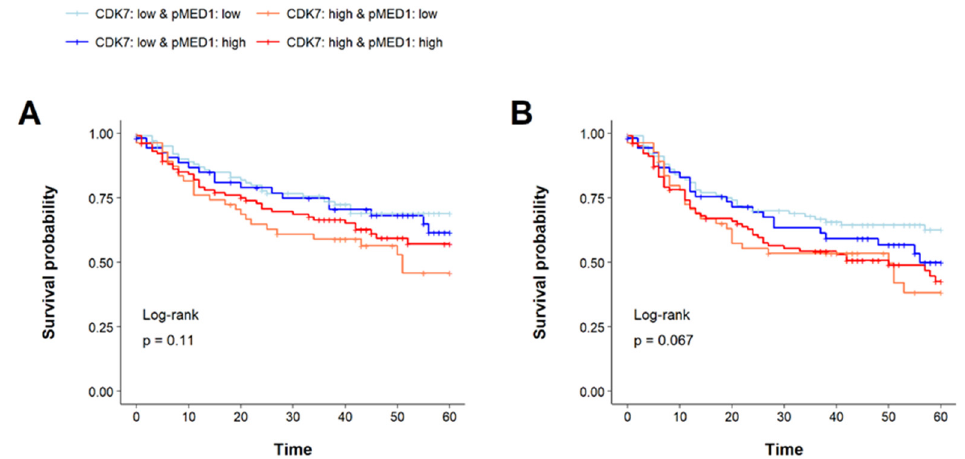
Figure 6. Kaplan–Meier graphs with p -values acquired from log-rank tests of ( A ) 5-year OS and ( B ) 5-year DFS. The cohort was stratified into four groups based on CDK7 and pMED1 expression. The expression above the median for the respective protein was considered as a high expression, the expression below the median as low expression. Based on this classification, four groups were formed to display all possible combinations of expression patterns. The log-rank tests revealed no significant difference in 5-year OS or 5-year DFS for the four groups. Nonetheless, we observed that curves grouped by CDK7 expression. There was a trend of shorter 5-year OS and 5-year DFS for both groups with high CDK7 expression compared to the two groups with low CDK7 expression. This effect seemed to be predominant and independent of the pMED1 expression level.